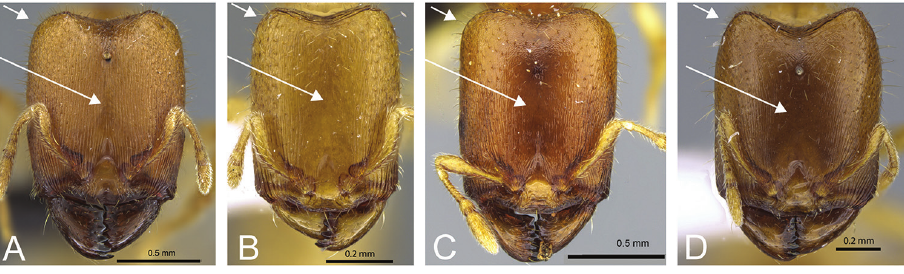
5 In full-face view posterolateral corners of head narrowing posteriorly and their prominent appearance enhanced by the relatively deep median impres- sion of the posterior margin (Fig. 6D) ...................................... C.